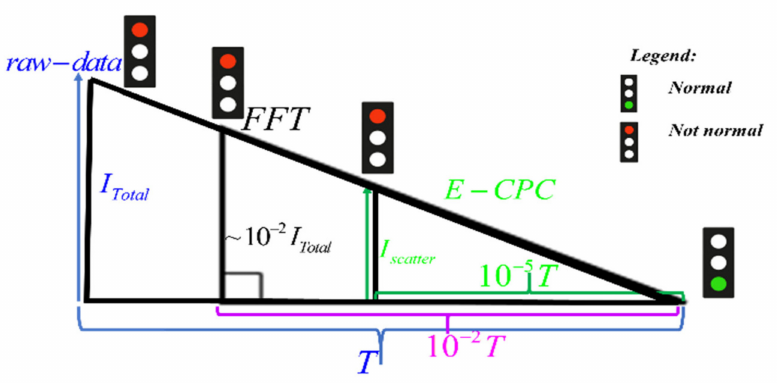
Figure 26. illustration explaining why E-CPC means less time, and fewer data as compared to FFT and raw